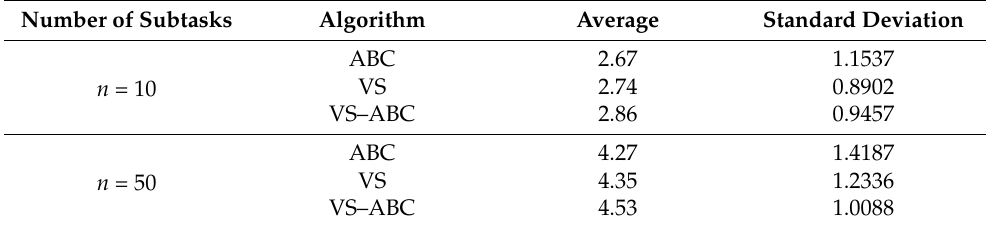
Table 17. Mean value and standard value of fitness in three algorithms.